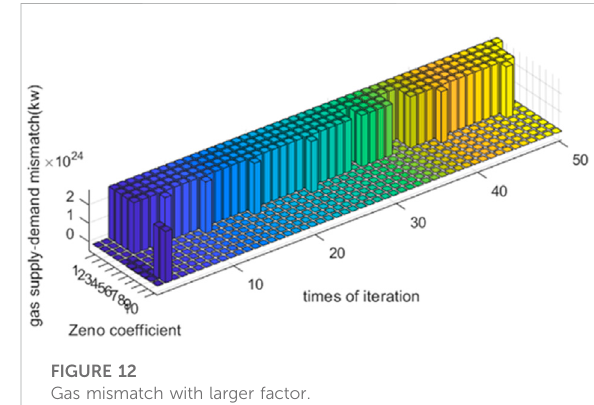
FIGURE 14 Emergency power scheduling.